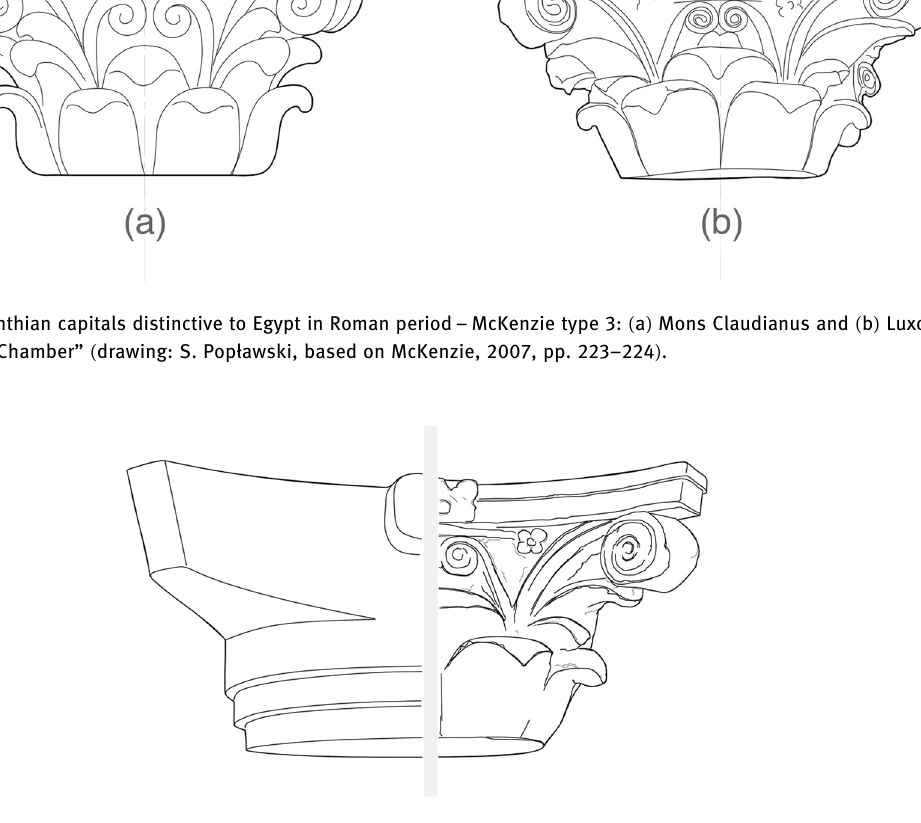
Figure 13: Comparison of the form of the blocked - out capital from Berenike and the Corinthian capital from the “ Imperial Chamber ” at Luxor ( drawing: S. Pop ł awski )